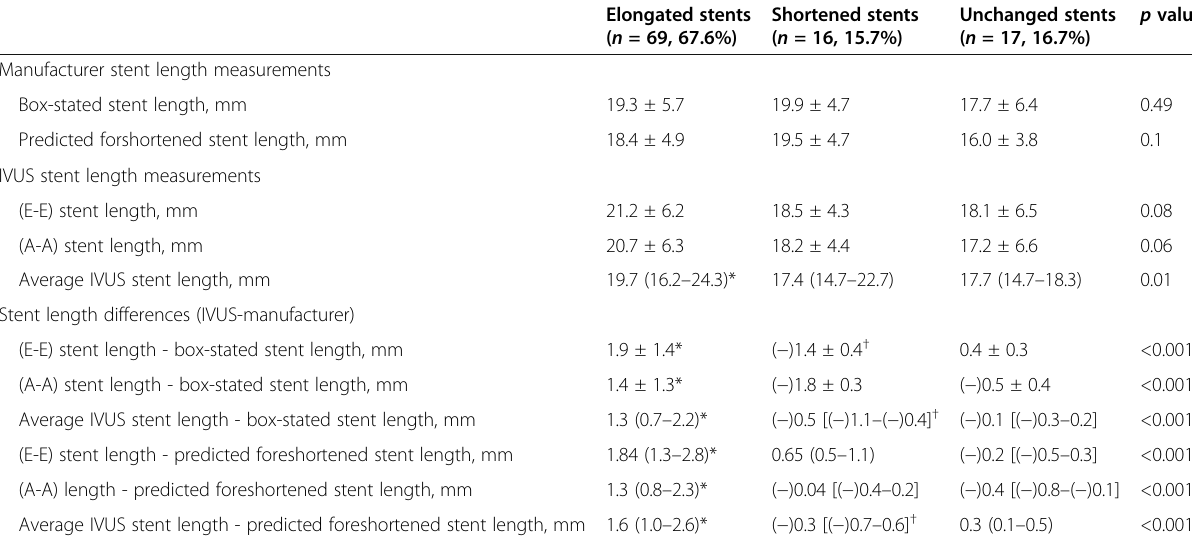
Table 4 IVUS and manufacturer stent lengths by groups